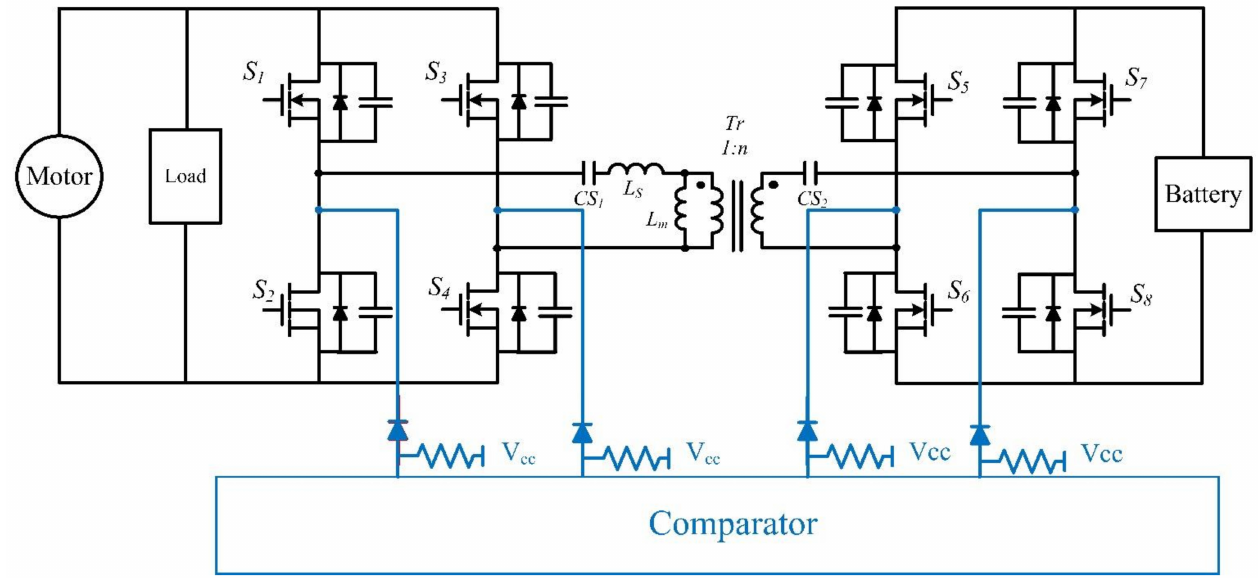
Figure 1. The proposed adaptive SR driving scheme for the bidirectional LLC resonant converter.